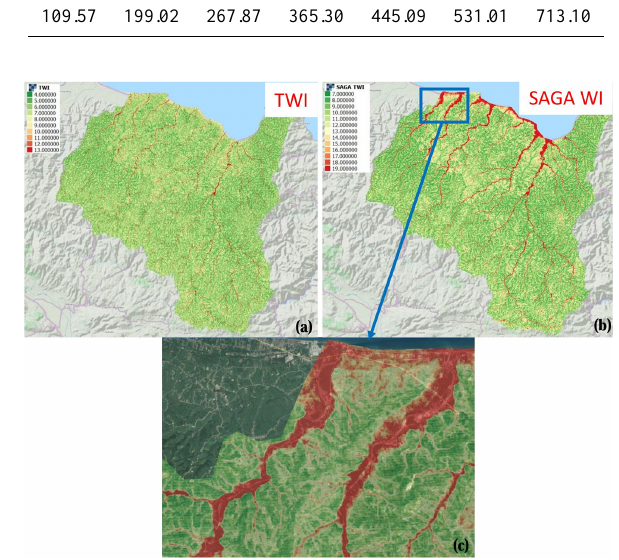
Figure 4. Regional-scale analysis of Ikizce watershed, (a) TWI, (b) SAGA WI; (c) a close-up view of downstream area of Akçay